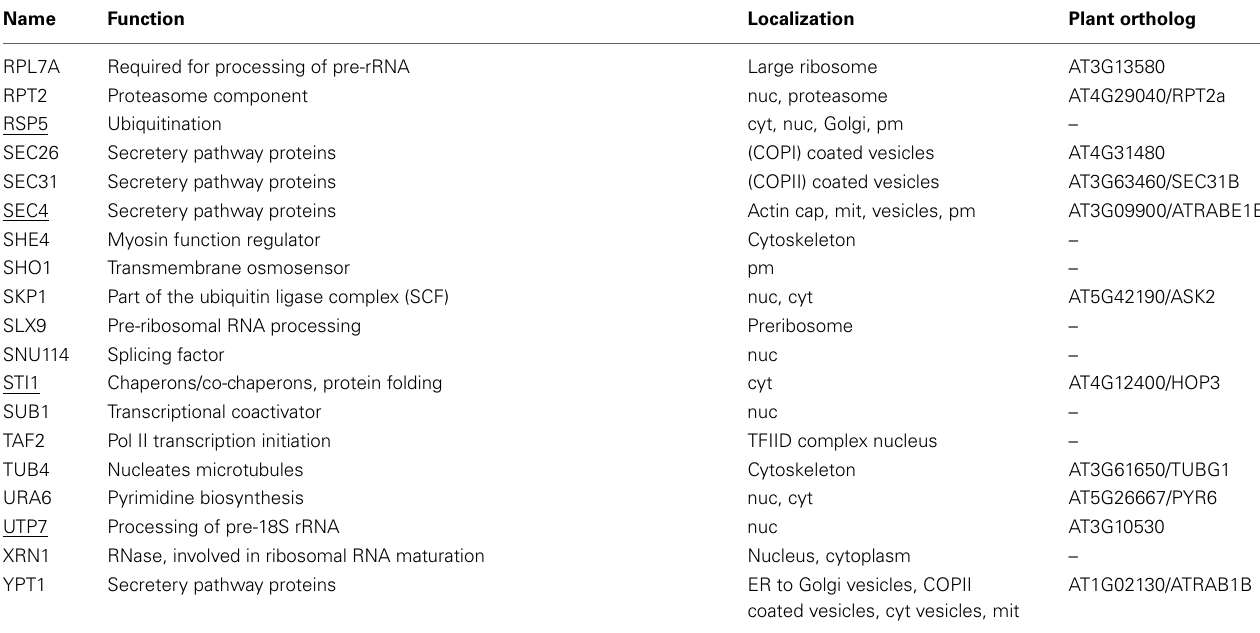
protein ( Figure 2 , marked with arrows and Figure 3 ). The